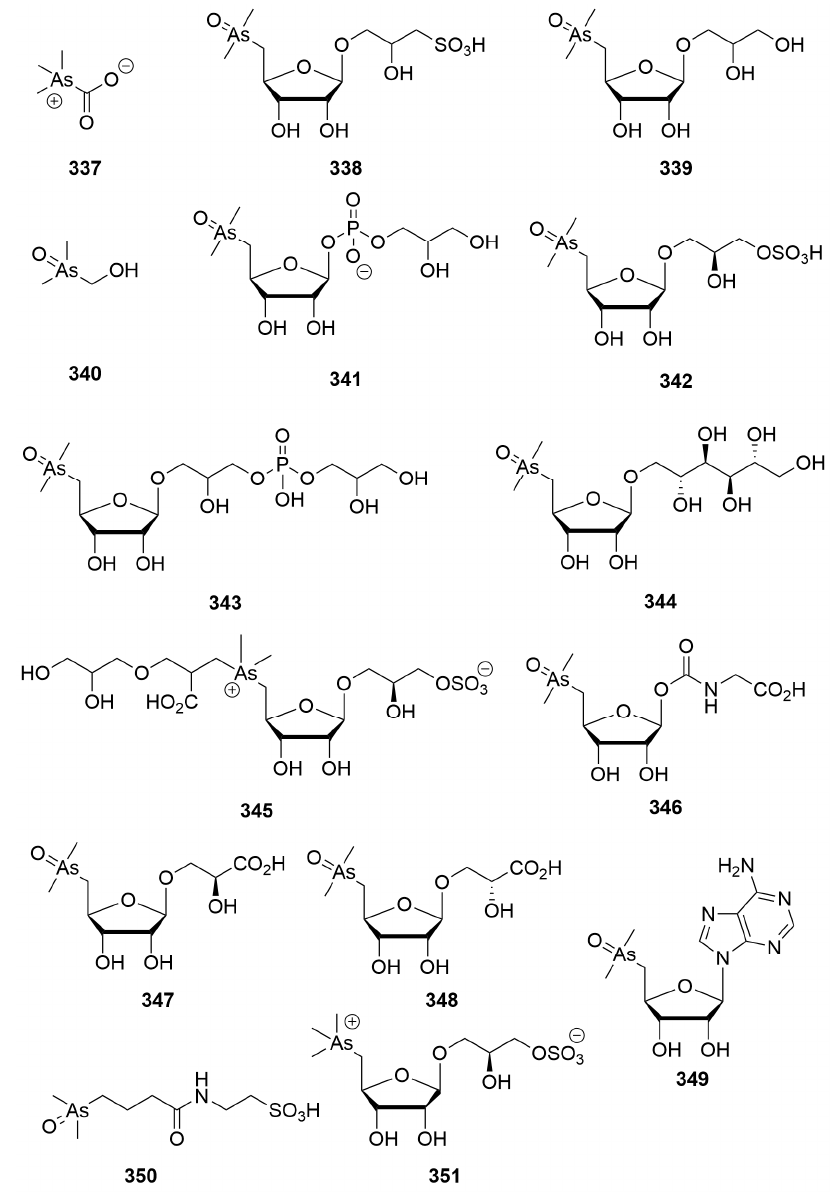
Figure 21. Compounds 337 to 351 .